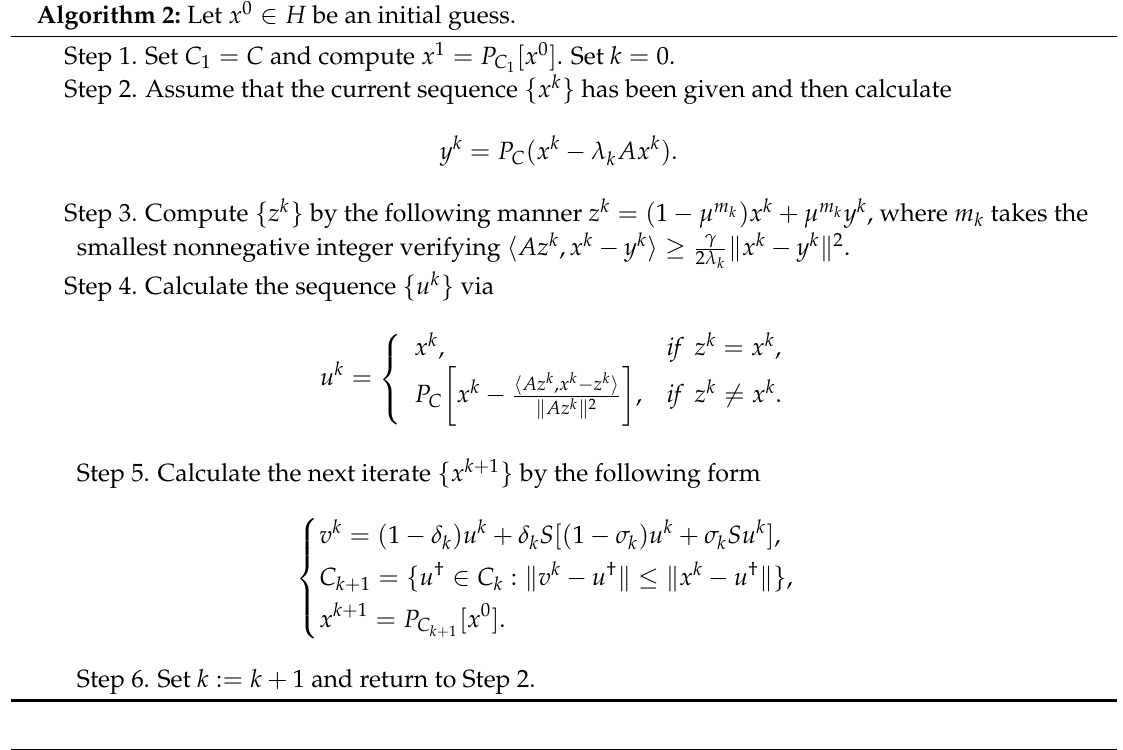
Algorithm 3: Let x 0 ∈ H be an initial